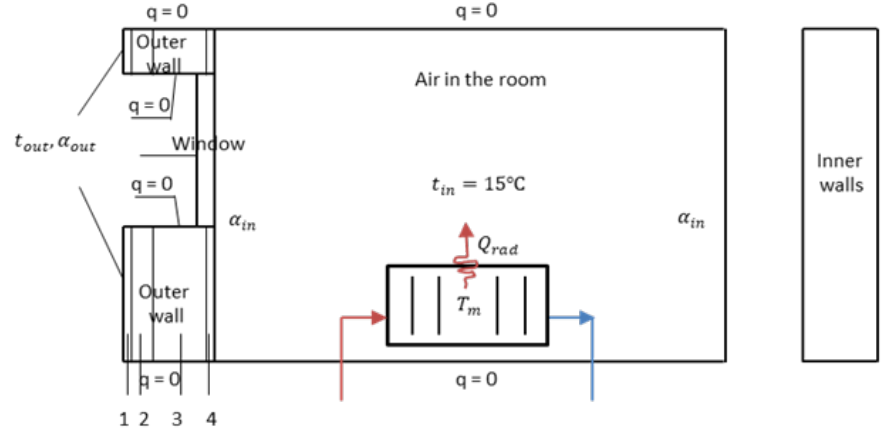
Figure 5. Geometry for test cases 1, 2, and 3.